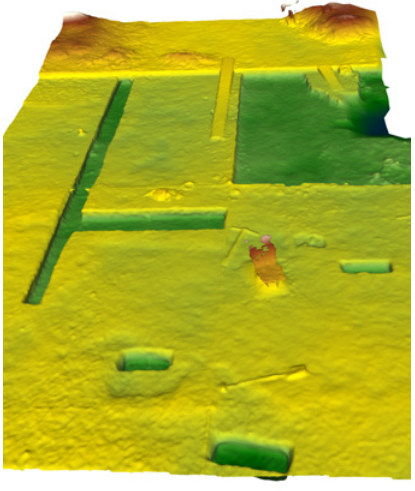
Figure 9: 3D model of planum three of the excavation at Hass-